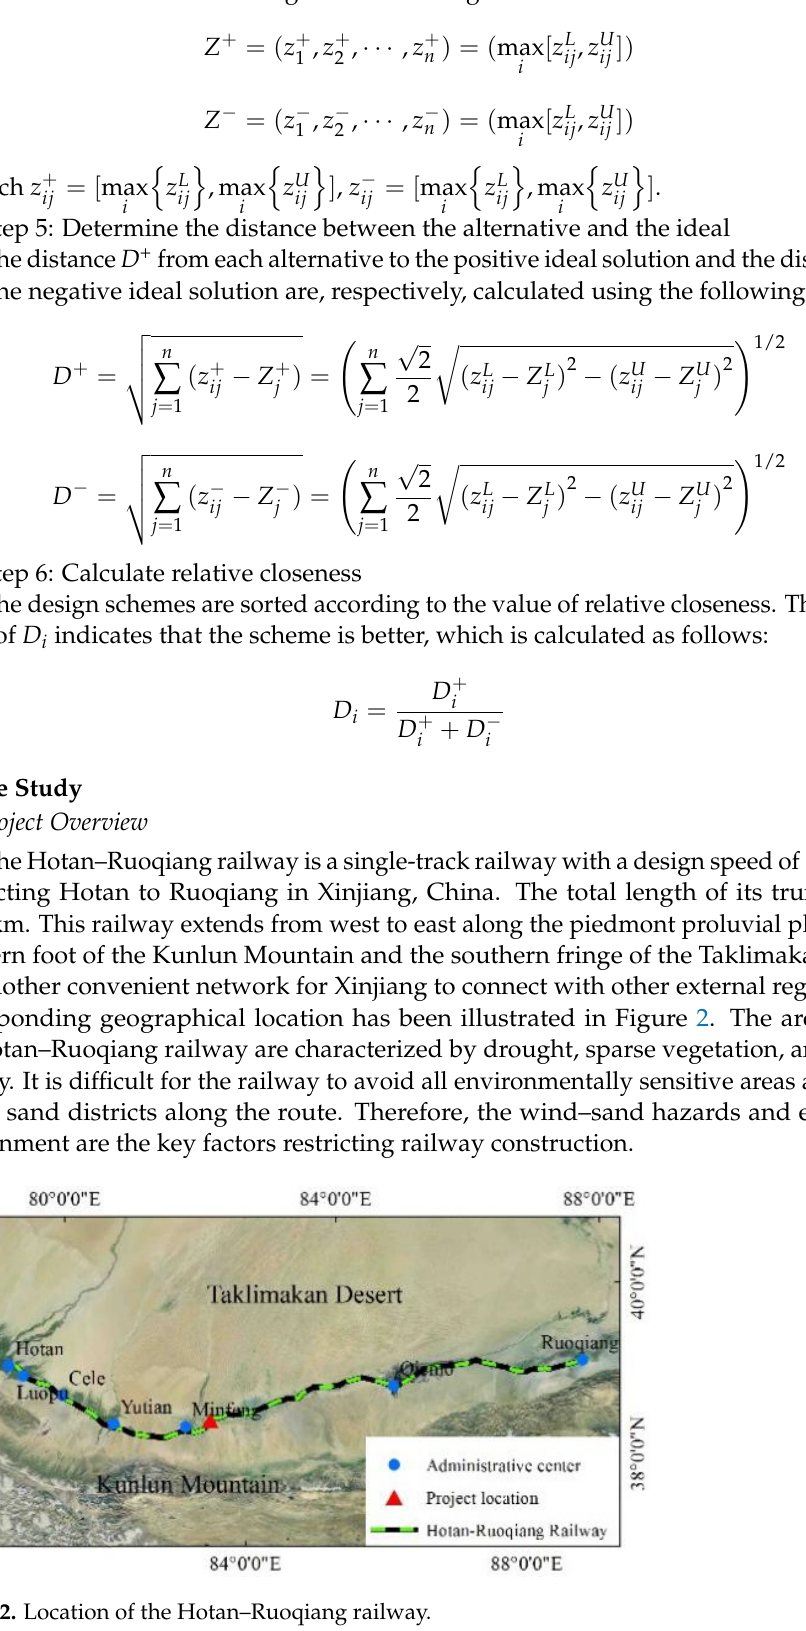
Figure 2. Location of the Hotan–Ruoqiang railway.